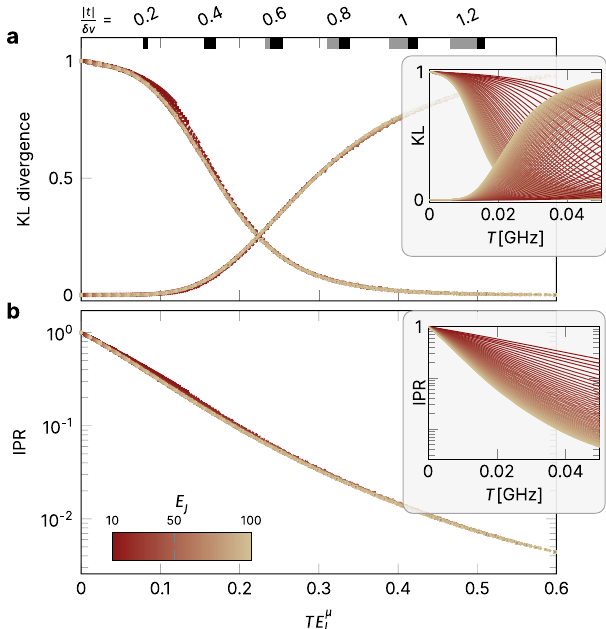
Fig. 8 Data collapse. The individual traces of the KL divergence and IPR, underlying the phase diagrams of Fig. 4 and shown in the two insets, are collapsed onto each other by rescaling the coupling parameter with respect to the Josephson energy as T ! TE μ J with an exponent μ ≈ 0.54. As TE ν t j = δ ν (cid:5) E μ (cid:2) 1 = 2 TE μ J (cid:6) j J , a J interval, whose lower (upper) bound is determined by the minimal (maximal) E J value, belongs to each ∣ t ∣ / δν value. The areas shaded in black indicate the TE μ J range associated with the ∣ t ∣ / δν label next to it. The upper boundary corresponds to E J = 100 GHz. The lower boundary is obtained for the smallest E J for which data points at that particular ∣ t ∣ / δν exist. The lower boundary of the gray-shaded interval corresponds to E J = 10 GHz, the smallest Josephson energy considered in the data collapse.